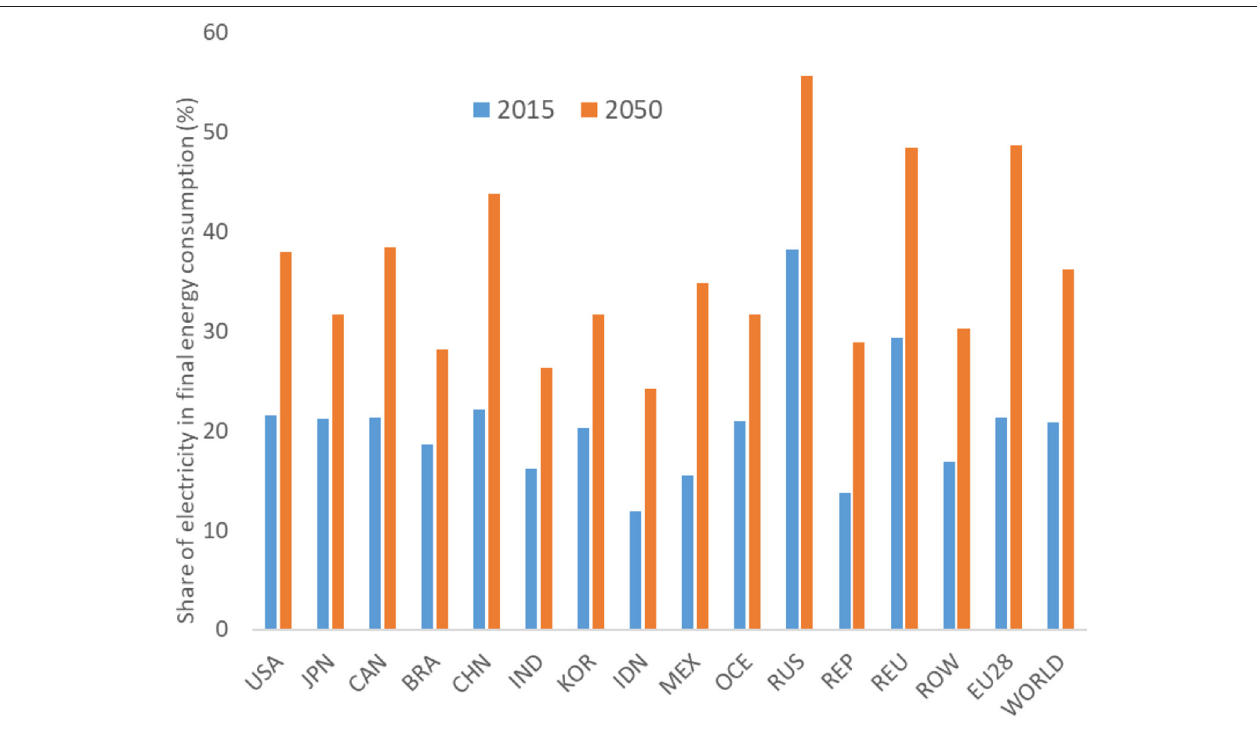
FIGURE 9 | Share of electricity in final energy consumption in the 2DEG scenario.